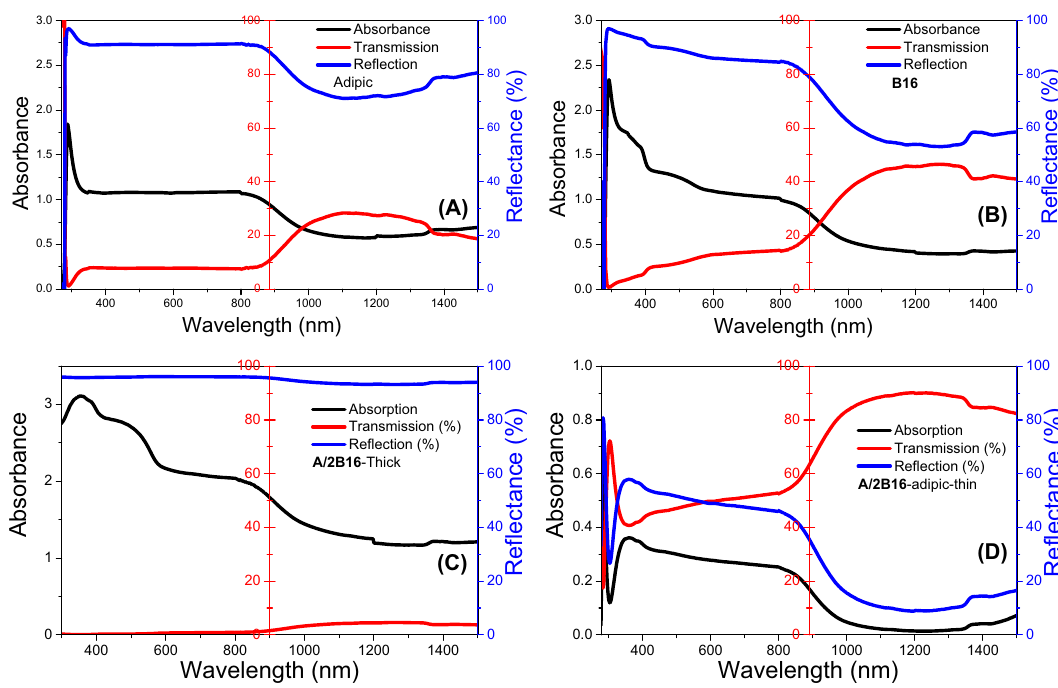
Figure 12. Optical spectra of ( A ) Adipic film, A ; ( B ) Azopyridine, B16 and ( C ) their complex A/2B16 ( C ) thick film and ( D ) thin